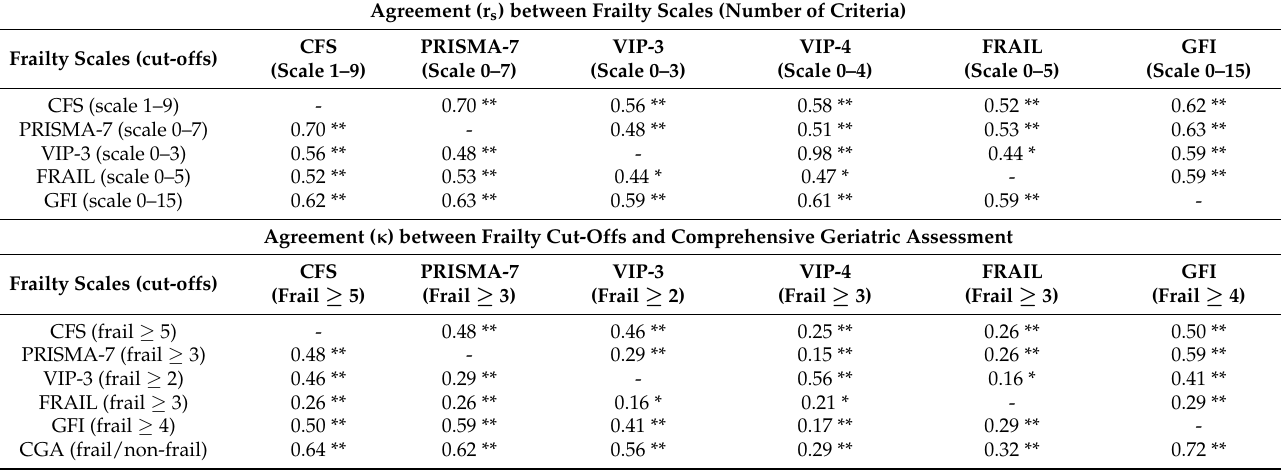
Table 2. Agreement between frailty scales, frailty cut-offs and comprehensive geriatric assessment frailty status according to Spearman’s correlation (r s ) for the number of criteria, and Cohen’s kappa ( κ ) for established, binary frailty cut-off